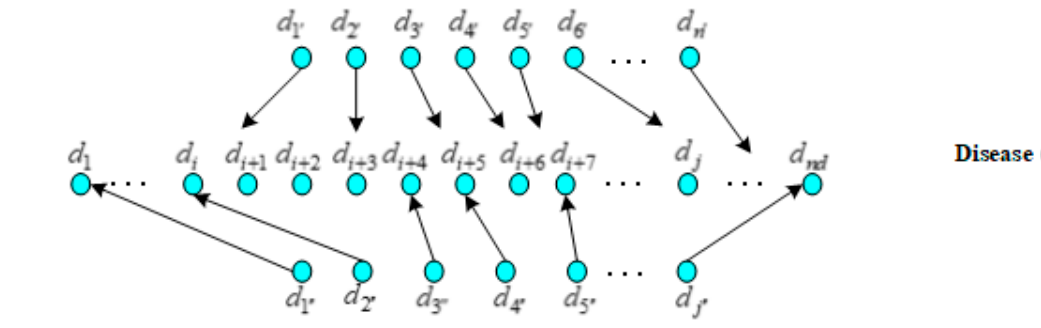
Figure 4. The mapping relations of the diseases associated with different lncRNAs.